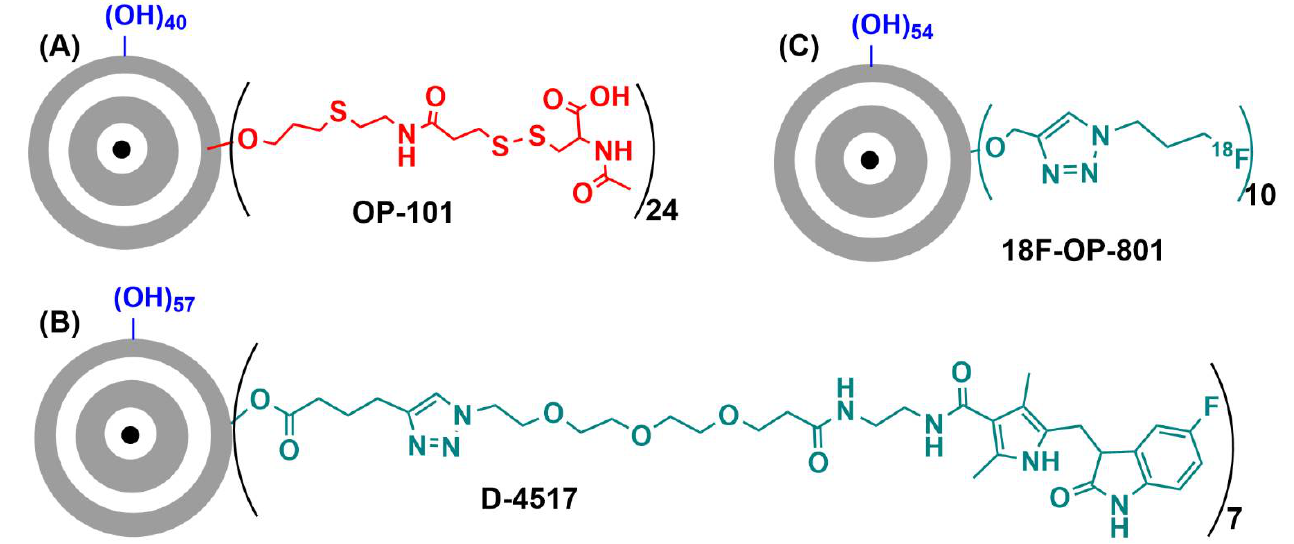
Figure 6. ( A ) Simplified structure of OP-101. ( B ) Simplified structure of D-4517. ( C ) Simplified structure of 18F-OP-801.